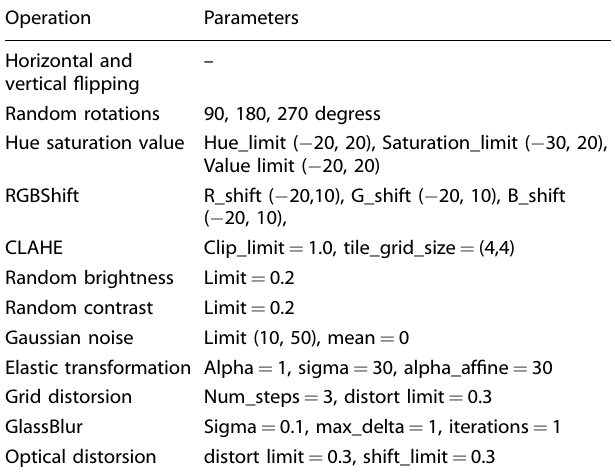
Table 6. Operations involved in the MoCo